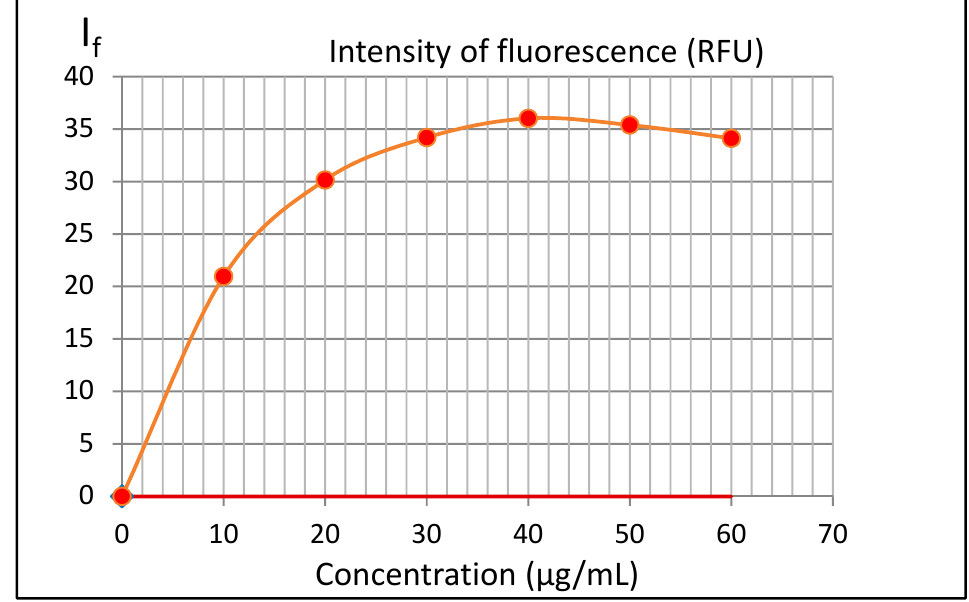
Figure 7. Intensity of fluorescence emission I f as a function of 3-aminoflavone concentration in methanol. The fluorescence was measured in cuvette with a path length l of 1 cm. For excitation and emission, filters with wavelengths of 350 nm and 470 nm were used, respectively.